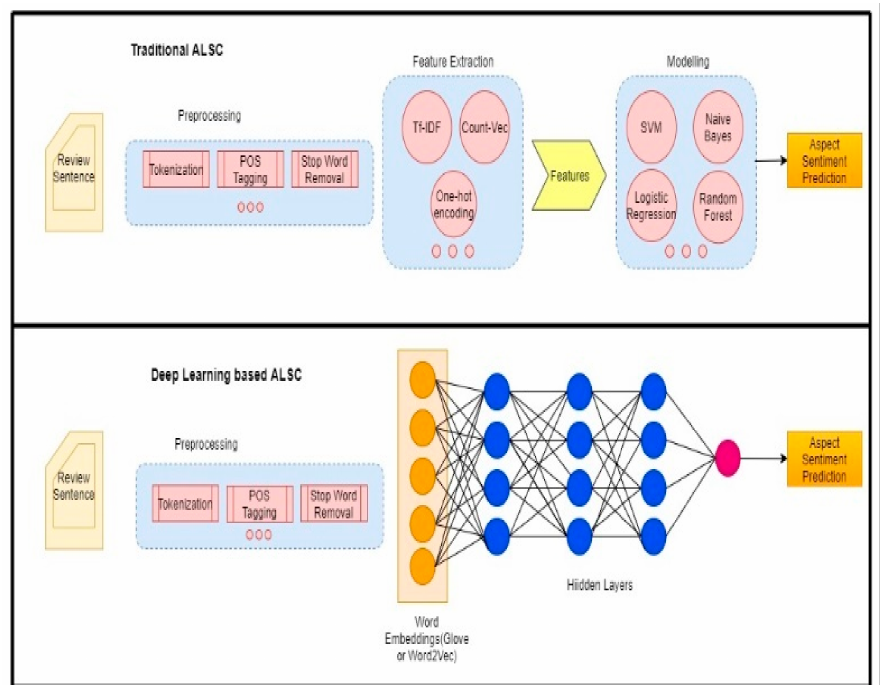
Figure 1. Traditional ALSC Vs. Deep Learning-based